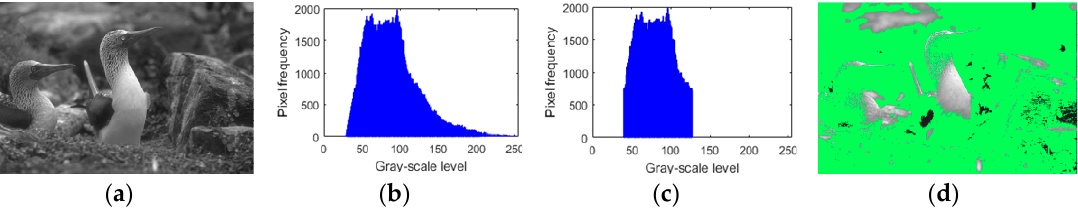
Figure 4. An example for histogram-based constraint rule for eliminating outliers. ( a ) Original “Birds” image; ( b ) the gray level histogram of ( a ); ( c ) the selected gray levels after the operation of histogram constraint rule; ( d ) The selected blocks according to ( c ) are labeled with green color.